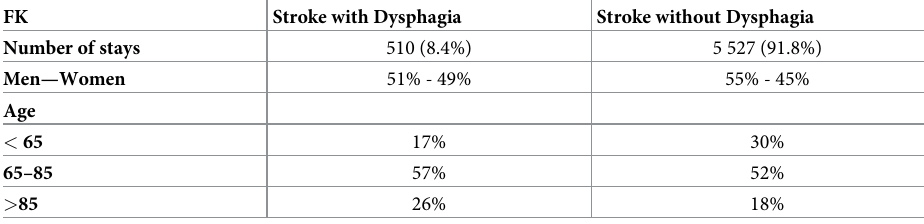
Table 2. Characteristics of stroke patients with dysphagia vs. without dysphagia in Switzerland.